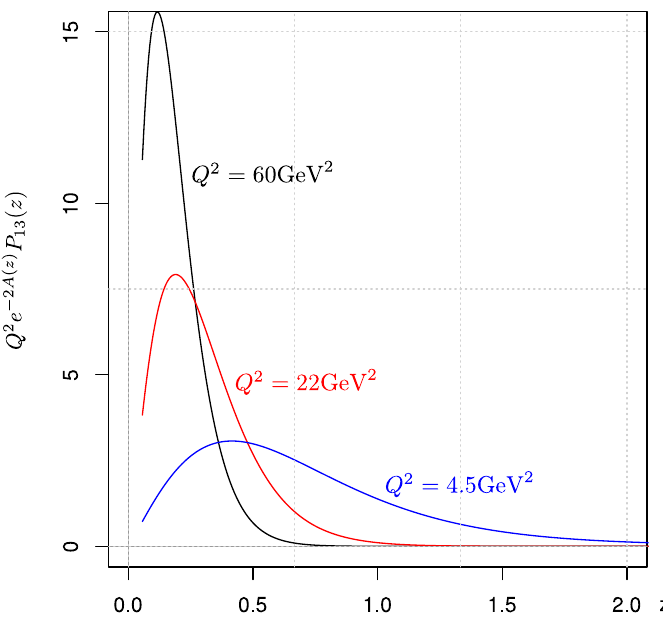
Figure 6 . The function previously approximated to a delta function in section 2. The quality of the approximation clearly decreases as Q 2 become